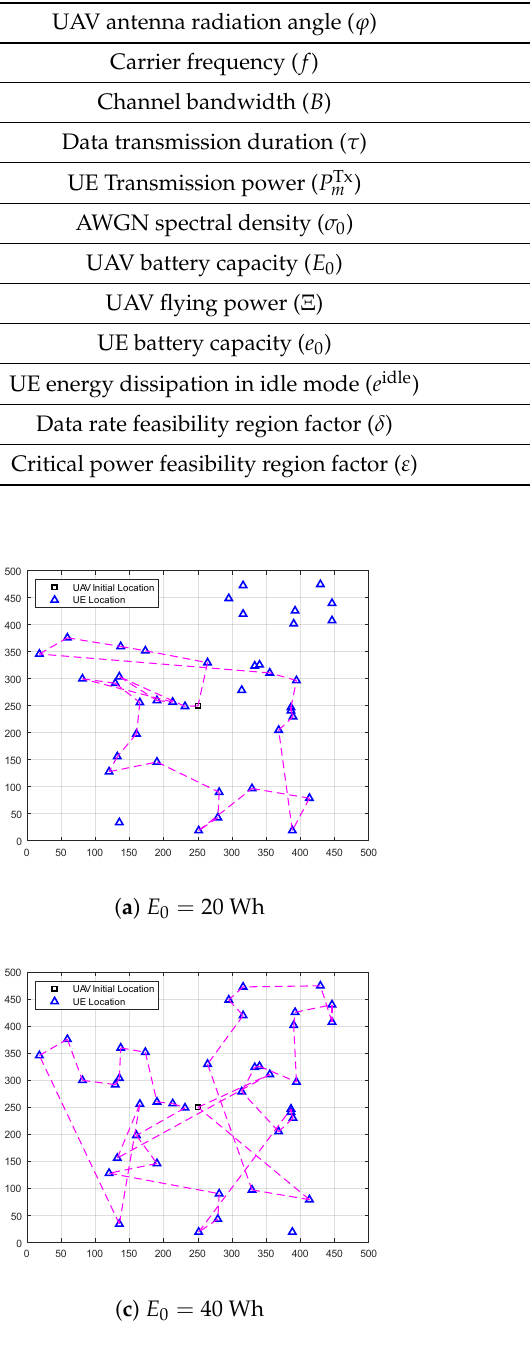
Figure 2. A sample of the UAV flight trajectory using the DEA-MAB algorithm. Figure 3 gives the long-term throughput for the data uploaded from UEs in the emergency wireless communication network. It is clearly visible that regardless of